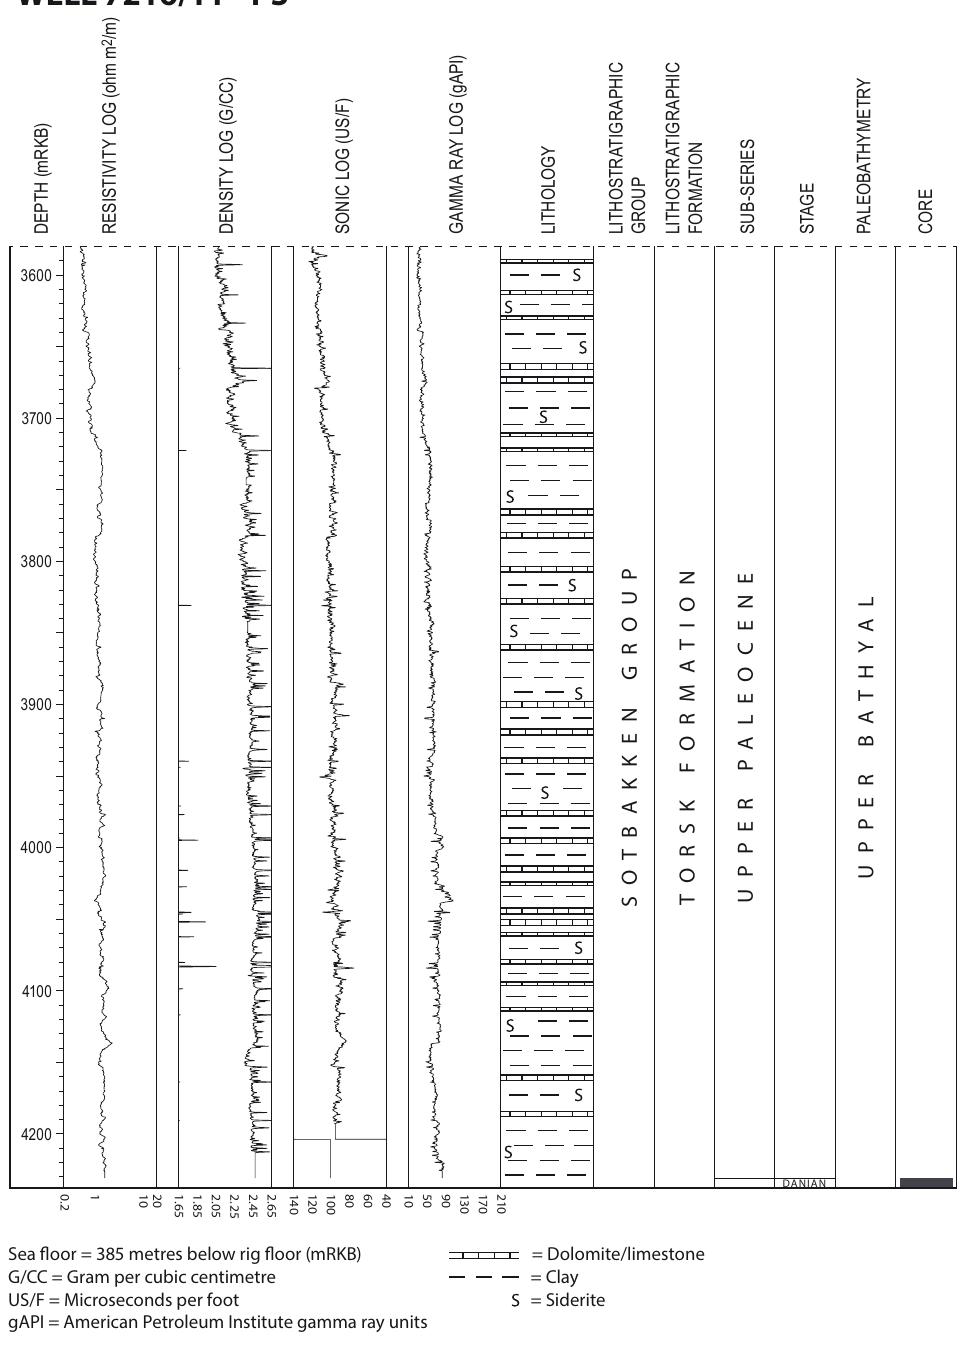
Figure 8. Well summary figure for well 7216/11–1 S including resistivity log, density log, sonic log, gamma-ray log, Fig. 8 lithology, lithostratigraphic units, sub-series, stage, paleobathymetry and core for the lower part of the supplementary well reference sections for the Torsk Formation (upper Paleocene; modified after Ryseth et al., 2003;